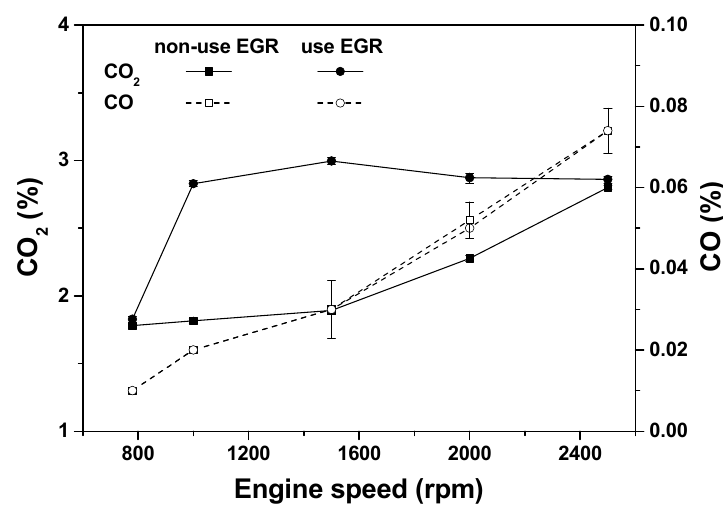
Figure 8. CO 2 and CO emissions with respect to engine speed and use / non-use of EGR